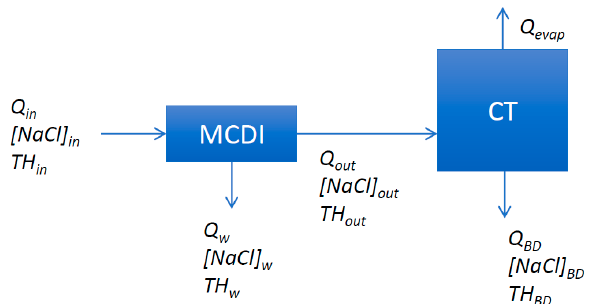
Figure 1. Process scheme for membrane capacitive deionization (MCDI) pretreatment of cooling tower 118 including mass balance components flow ( Q ), [NaCl] and hardness ( TH ) for MCDI feed ( in ),